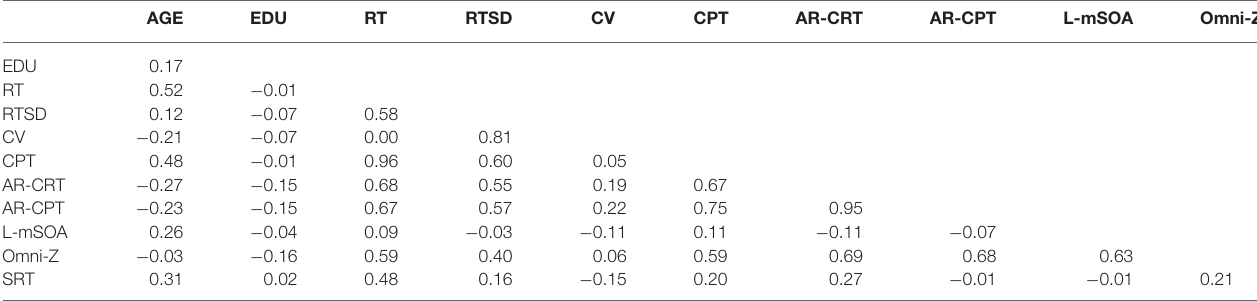
TABLE 4 | Correlation matrix for Experiment 2